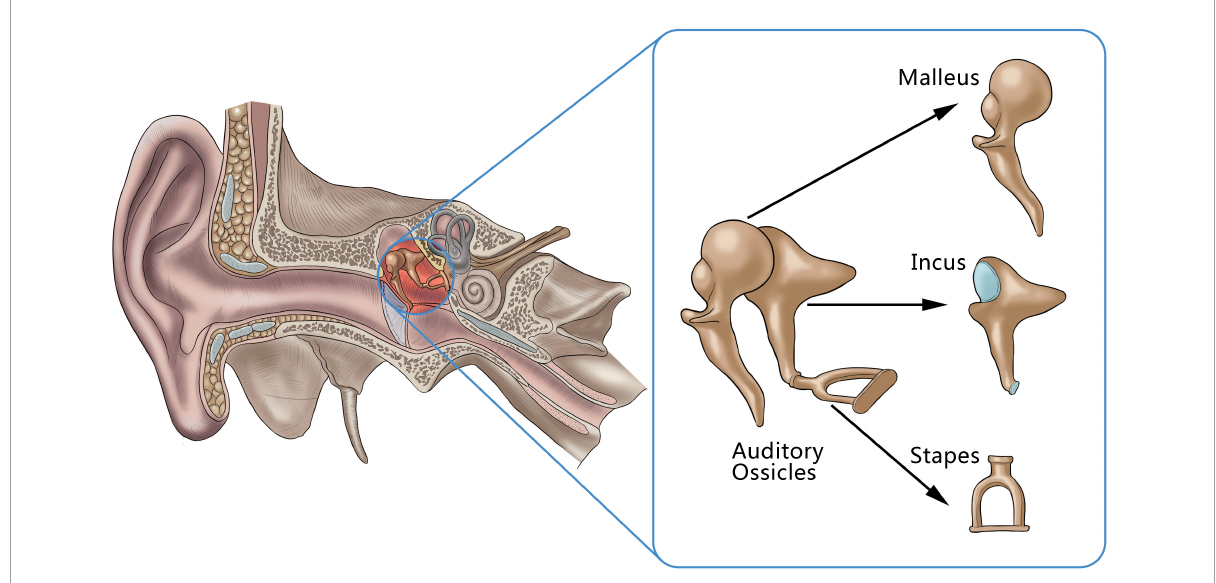
FIGURE1 An anatomical illustration of auditory ossicles located in the middle ear, including the malleus, incus, and